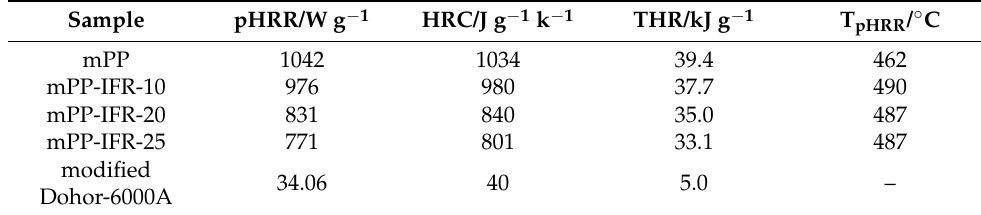
Table 5. Results of MCC tests.